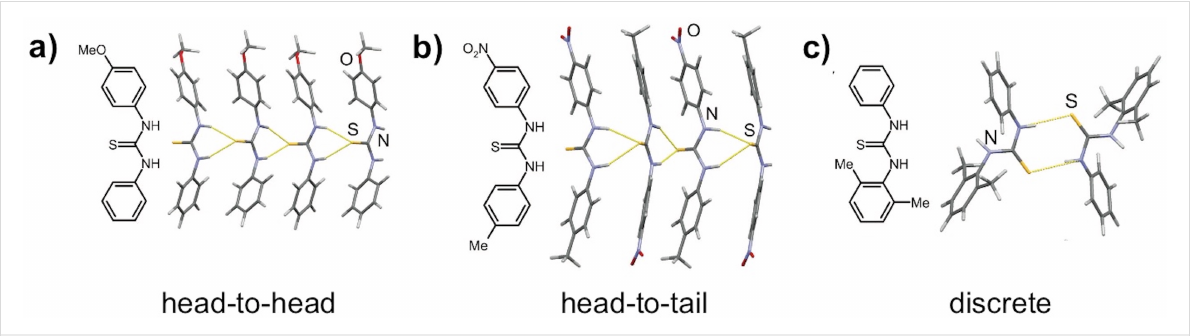
Figure 2: The supramolecular level of organization of thioureas in the solid-state.